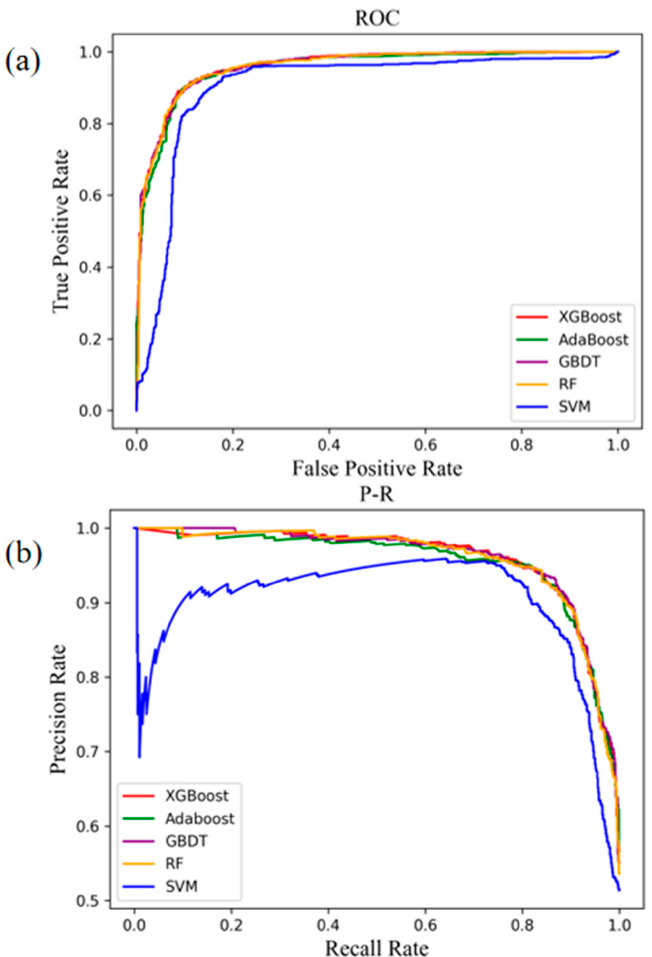
Figure 4. The ROC ( a ) and precision-recall (P-R) ( b ) curves of XGBoost, Adaboost, GBDT, RF, and SVM methods.